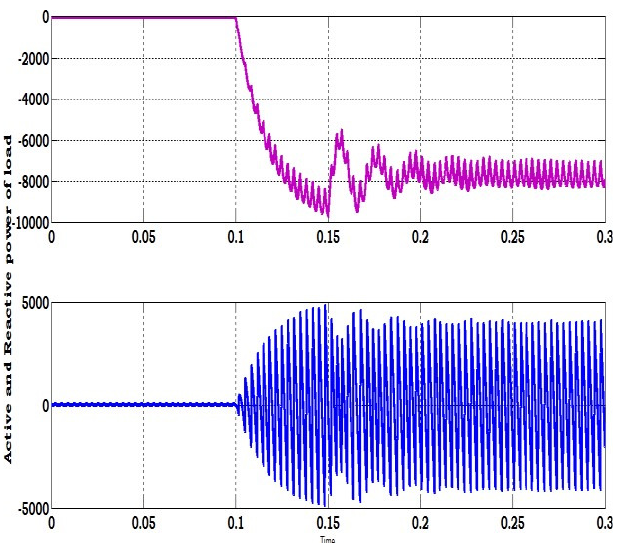
Figure 9. Waveform of Active and Reactive Power of Load